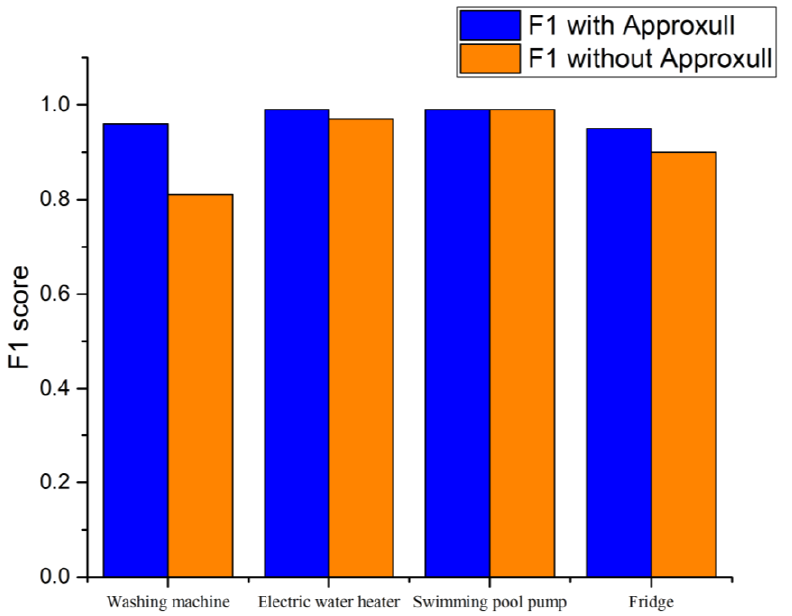
Figure 4. F1 score comparison without and with ApproxHull data selection algorithm.